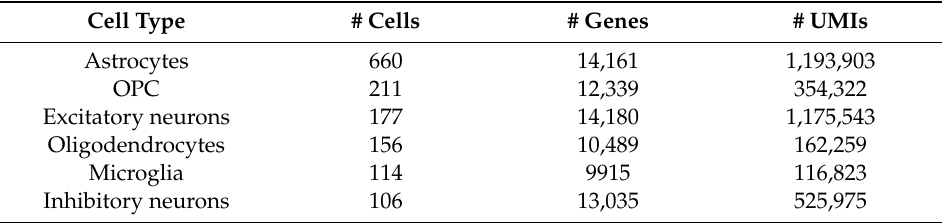
Table 2. Number of cells, protein coding genes and UMIs per cell type in our snRNA-seq